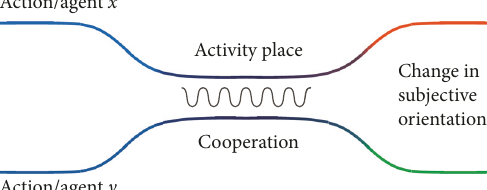
Figure 5: Aligning different actions in the cooperation process.